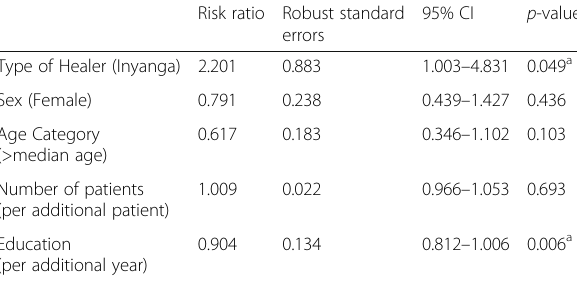
Table 2 Risk of intentionally treating HIV Risk ratio Robust standard 95% CI p -value errors Type of Healer (Inyanga)